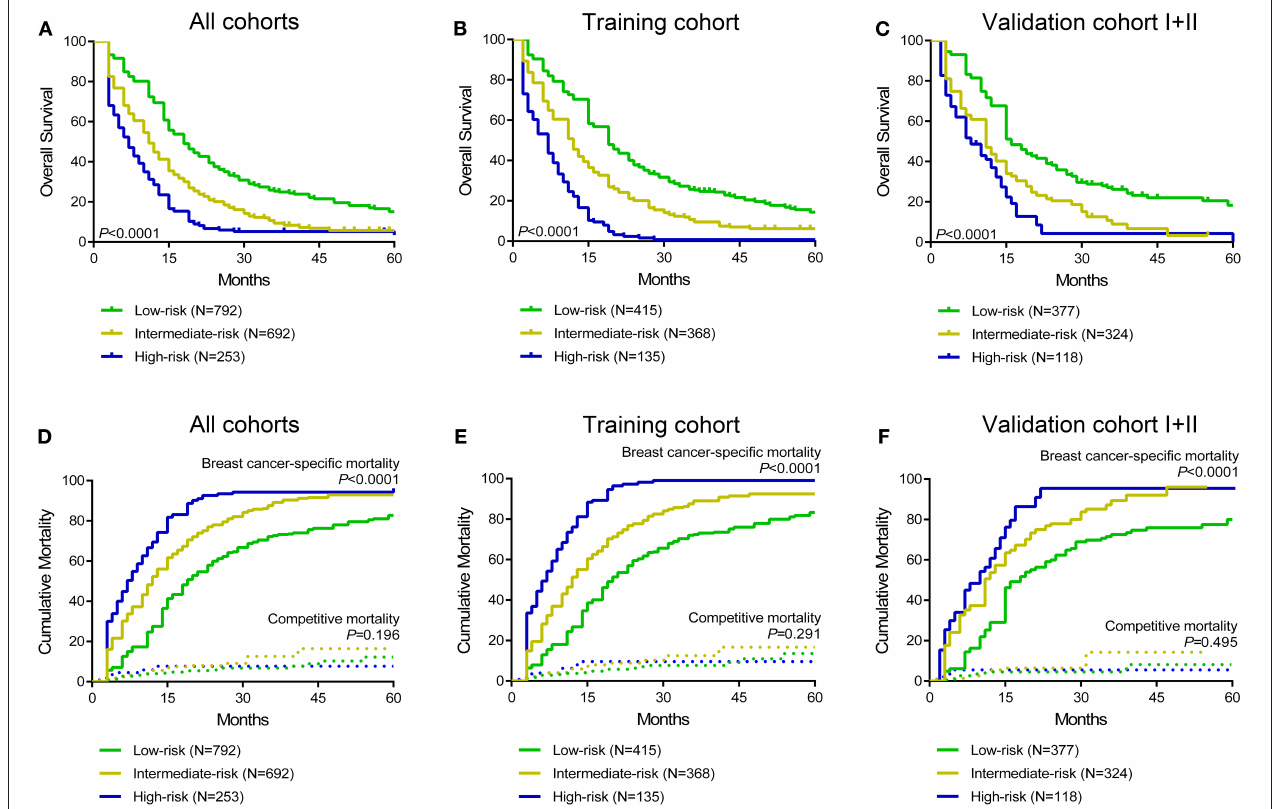
FIGURE 5 | Kaplan curves of low-, intermediate- and high-risk groups in all cohorts (A) , the training cohort (B) , and validation cohort I + II (C) . Cumulative breast cancer-specific and competitive mortality curves stratified by risk groups in all cohorts (D) , the training cohort (E) , and validation cohort I + II (F) .